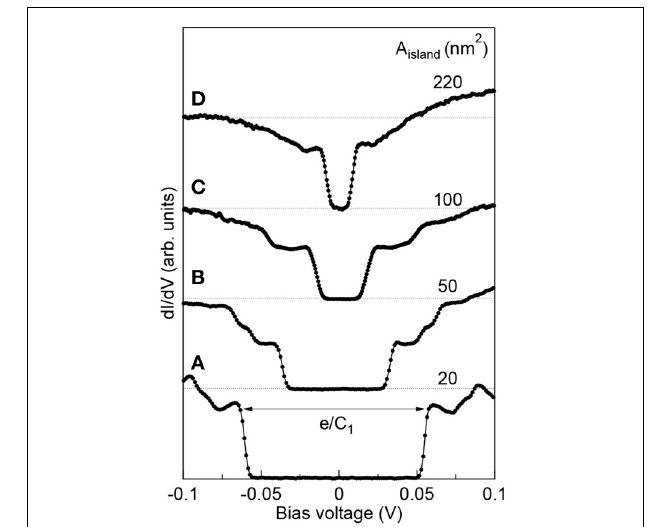
FIGURE 3 | dI/dV spectra labeled (A to D) acquired on four Pb islands with different area A island . A Coulomb gap of decreasing size is visible in going from spectrum ( A to D ) reflecting a Coulomb blockade